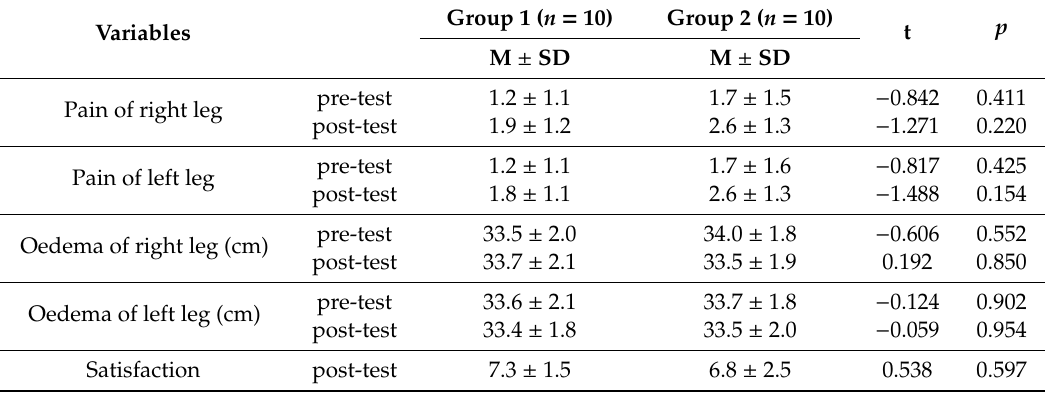
Table 2. Differences in pain, oedema, and satisfaction between groups according to length of compression stockings.